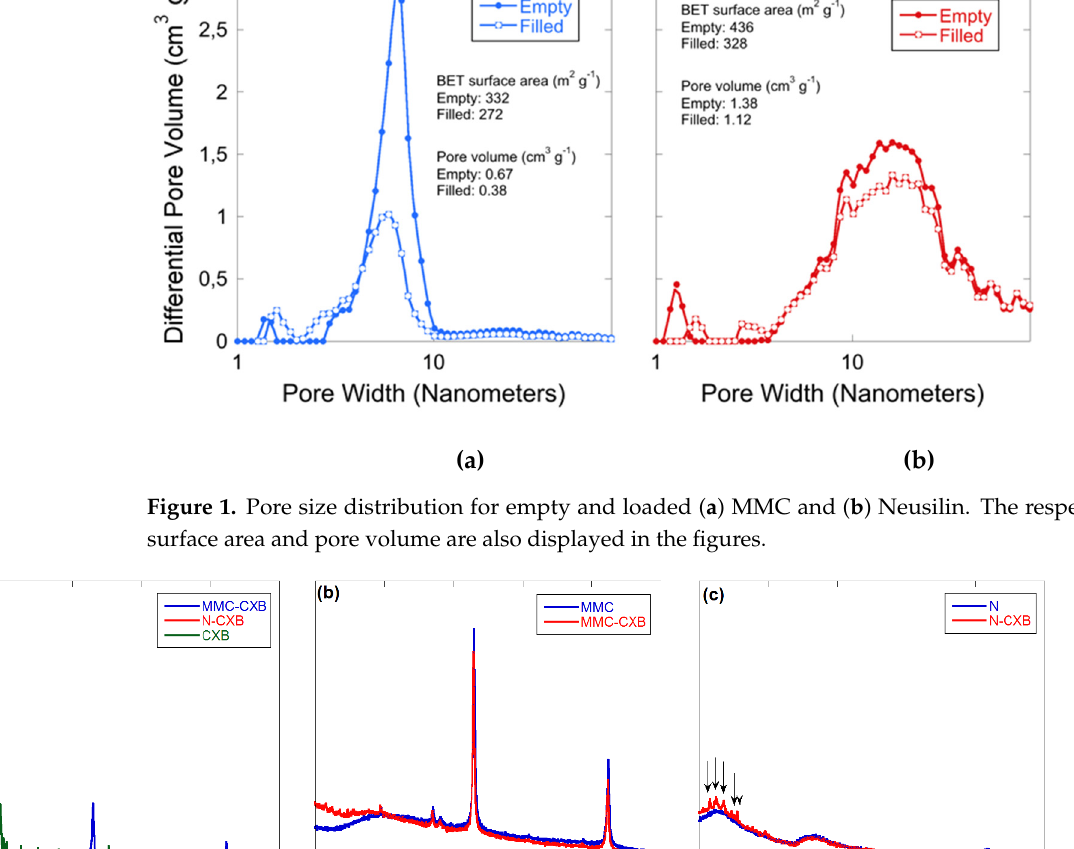
Figure 1. Pore size distribution for empty and loaded ( a ) MMC and ( b ) Neusilin. The respective surface area and pore volume are also displayed in the figures.